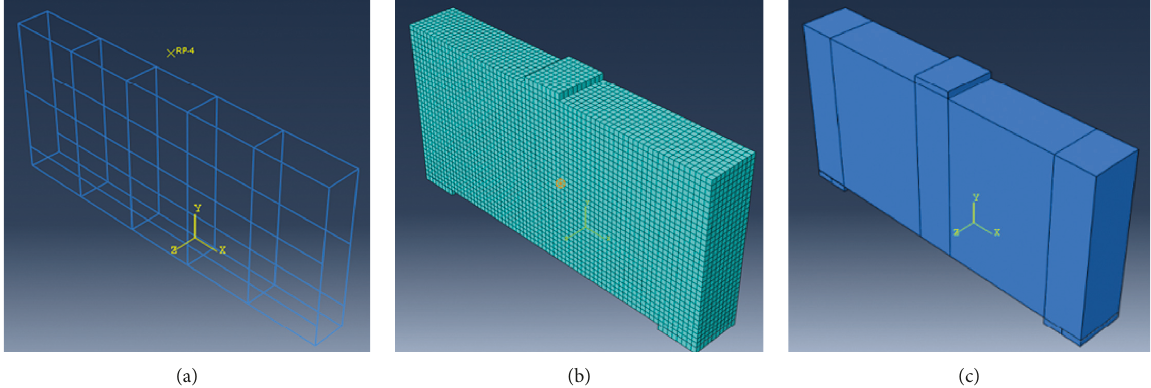
Figure 23: FE model of the HFRC deep beam: (a) steel reinforcements; (b) mesh generation; (c) deep beam model.